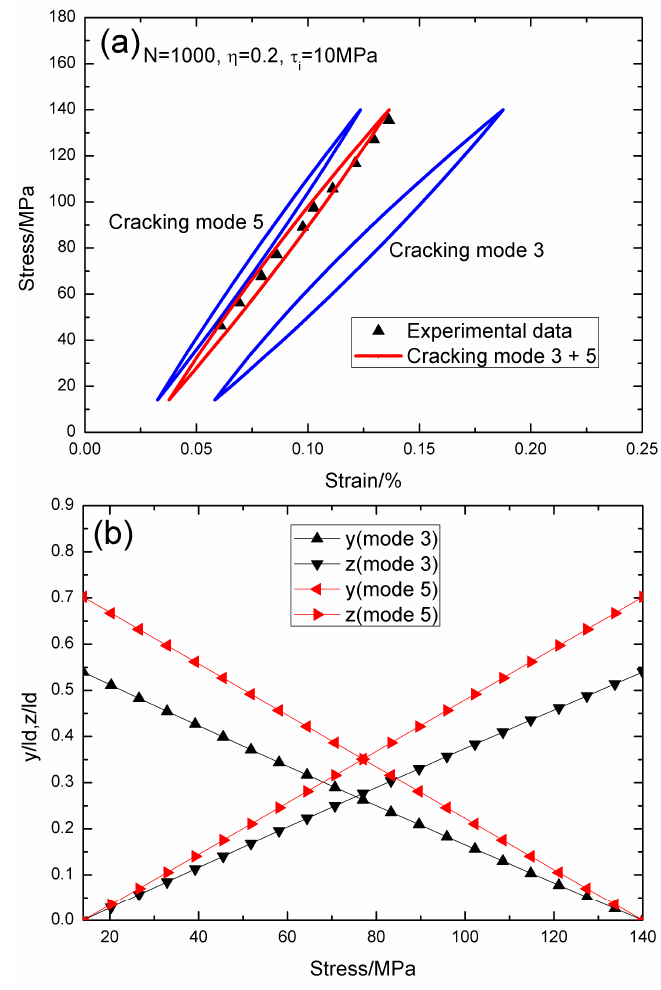
Figure 14. ( a ) The theoretical and experimental hysteresis loops; and ( b ) the interface slip lengths, i.e. , y / l d and z / l d , of matrix cracking modes 3 and 5 of 2D woven SiC/SiC composite under σ max = 140 MPa